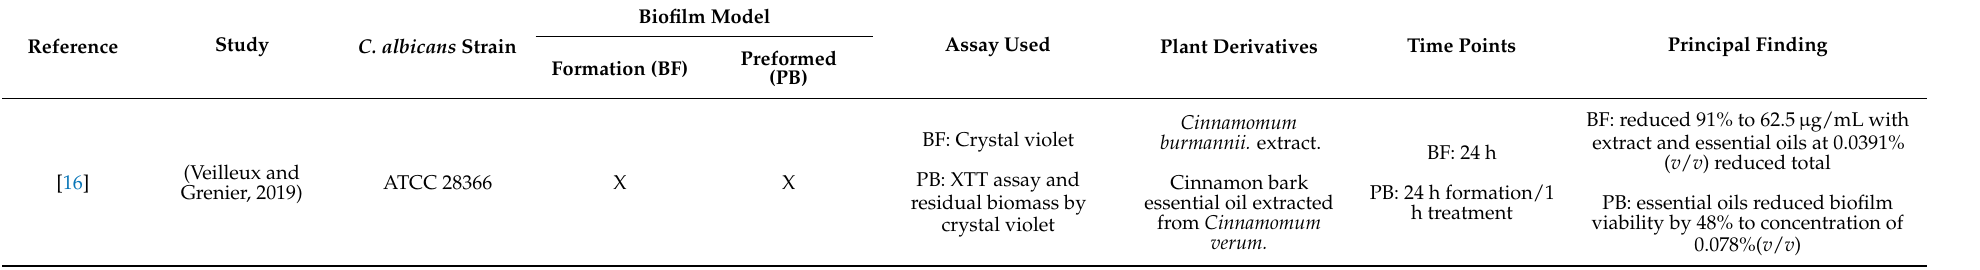
Table 4. Principal findings of studies that investigated the effect of plant derivatives on C. albicans